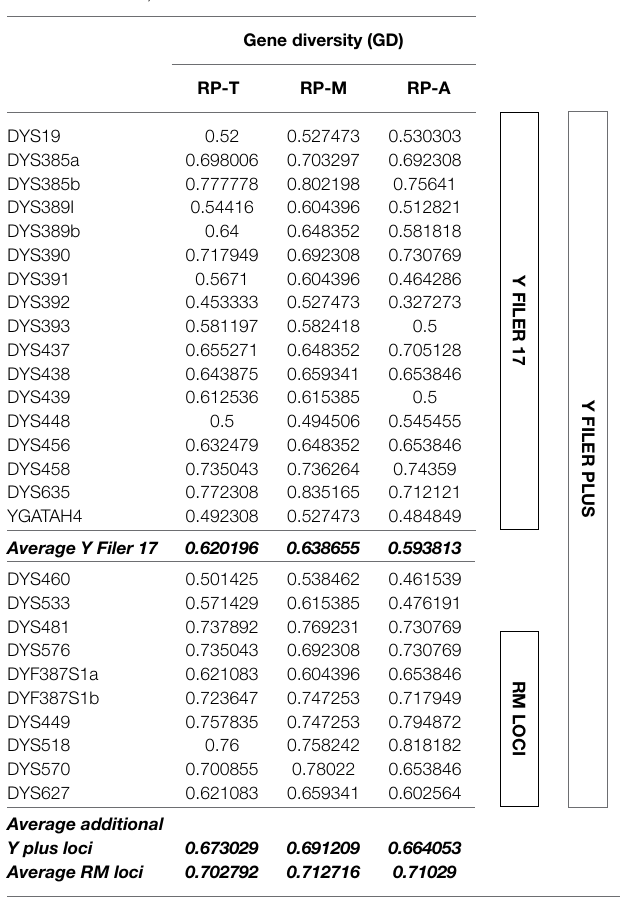
TABLE 4 | Genetic diversity for each Y-STR marker in the considered datasets (RP_T: whole samples from Roccapelago; RP_A: ancient mummies; and RP_M: modern